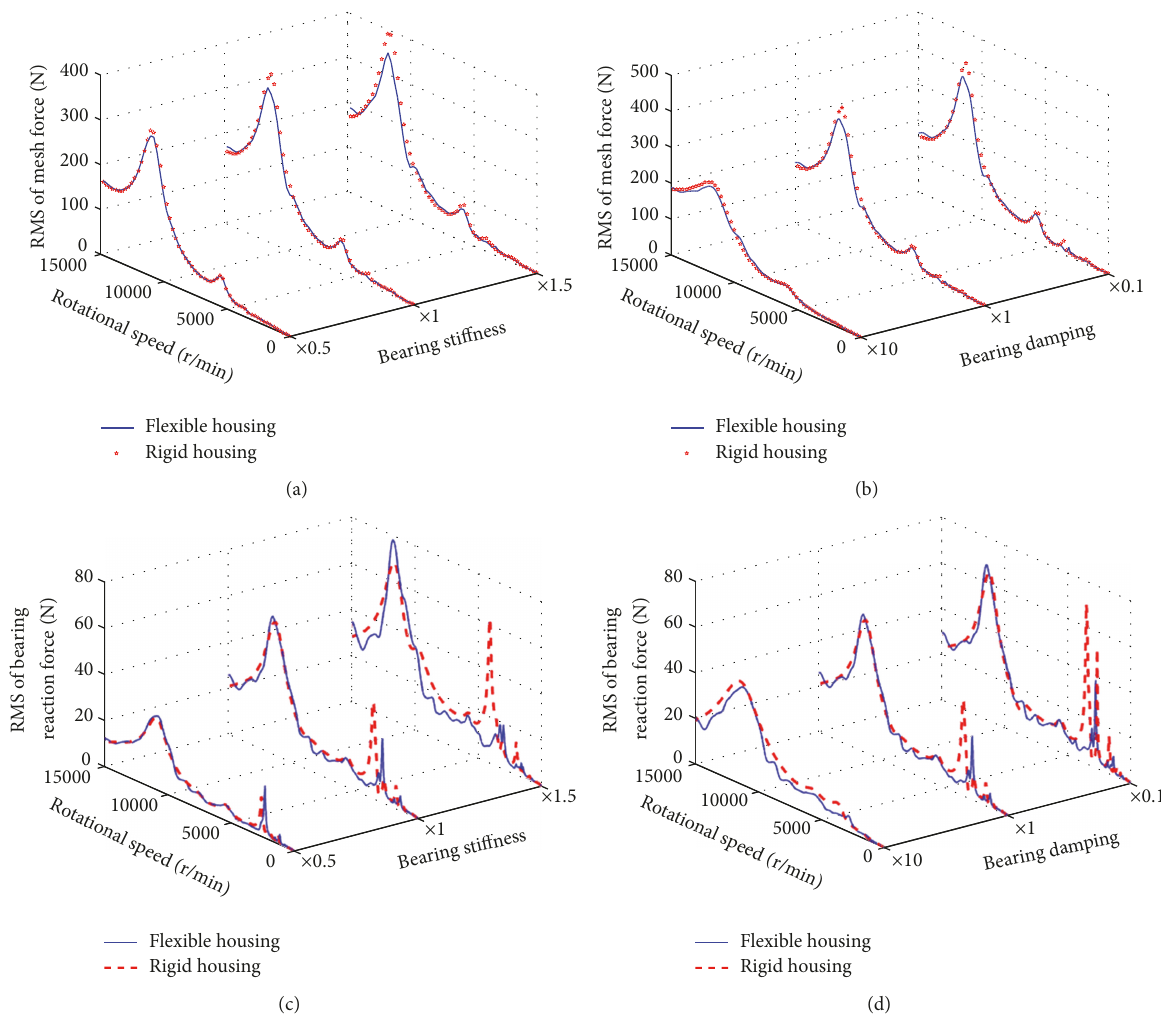
Figure13:Influenceofbearingpropertiesonhousingcontributiononsystemvibration:(a)bearingstiffness,meshforce;(b)bearingdamping, mesh force; (c) bearing stiffness, bearing reaction load; (d) bearing damping, bearing reaction